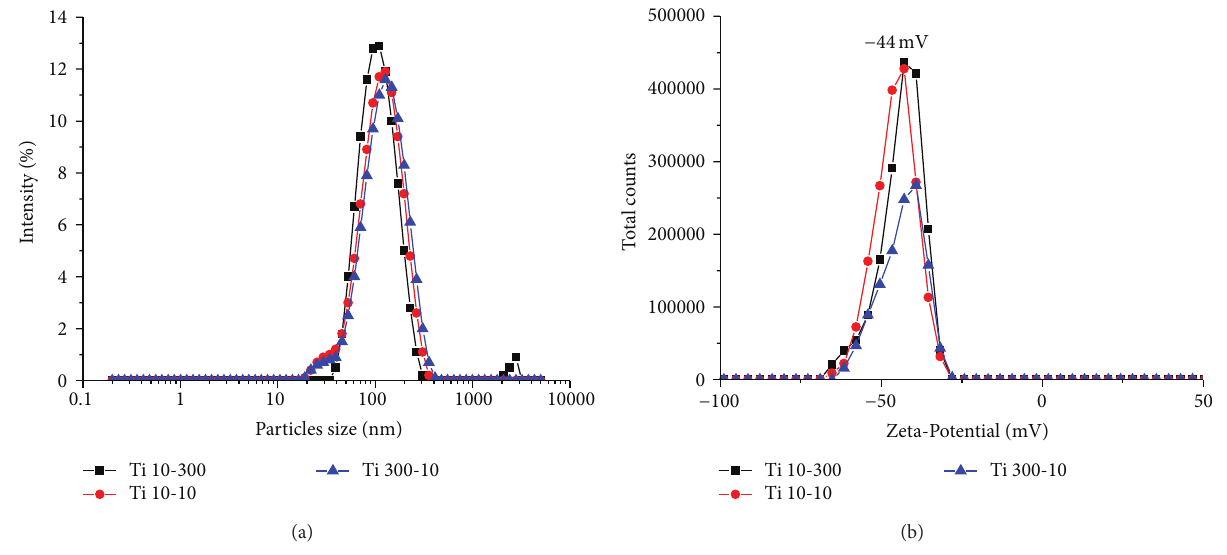
Figure 10: Nanotitanium fluid. (a) Particles size analysis; (b) Zeta-Potential analysis.